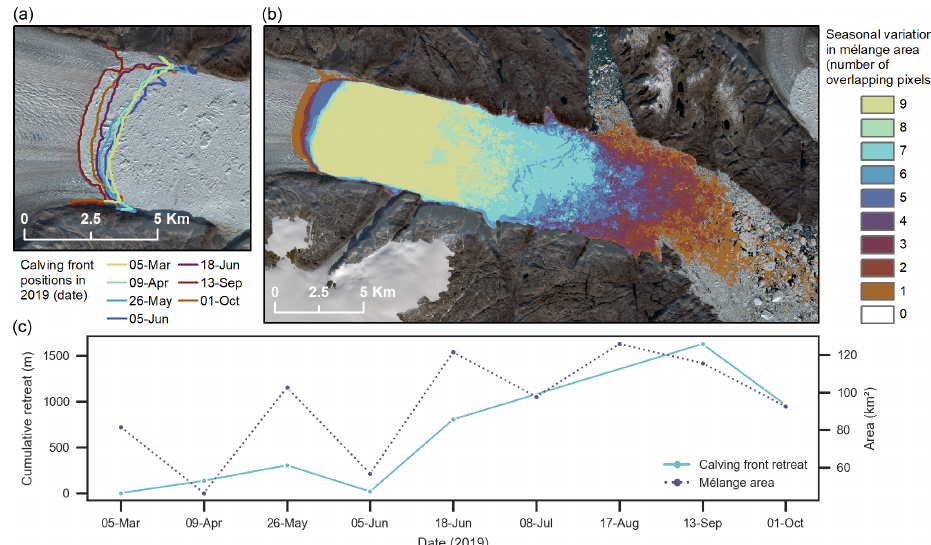
Figure 10. (a) Time series of Helheim calving front positions produced from CSC outputs of the 2019 test data. (b) Frequency of CSC- predicted mélange pixels from the Helheim test dataset showing the seasonal variation in mélange extent. (c) Cumulative retreat of the calving front relative to 5 March 2019 and mélange area for each test image. All background Sentinel-2 imagery in this figure has been made available courtesy of the European Union Copernicus